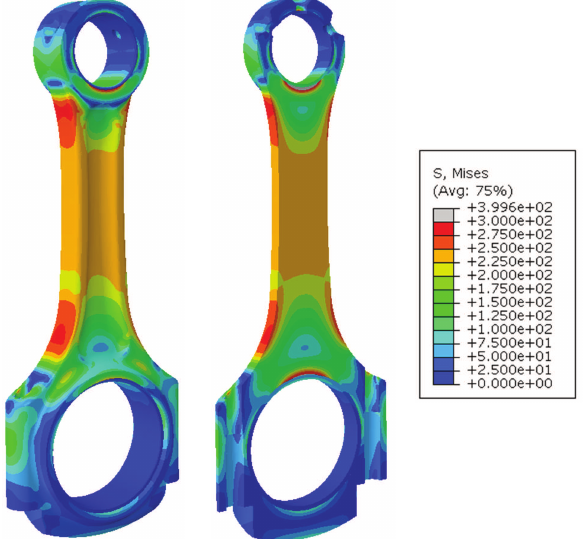
Fig. 5. Results of simulation tests, connecting rod compression 1 version